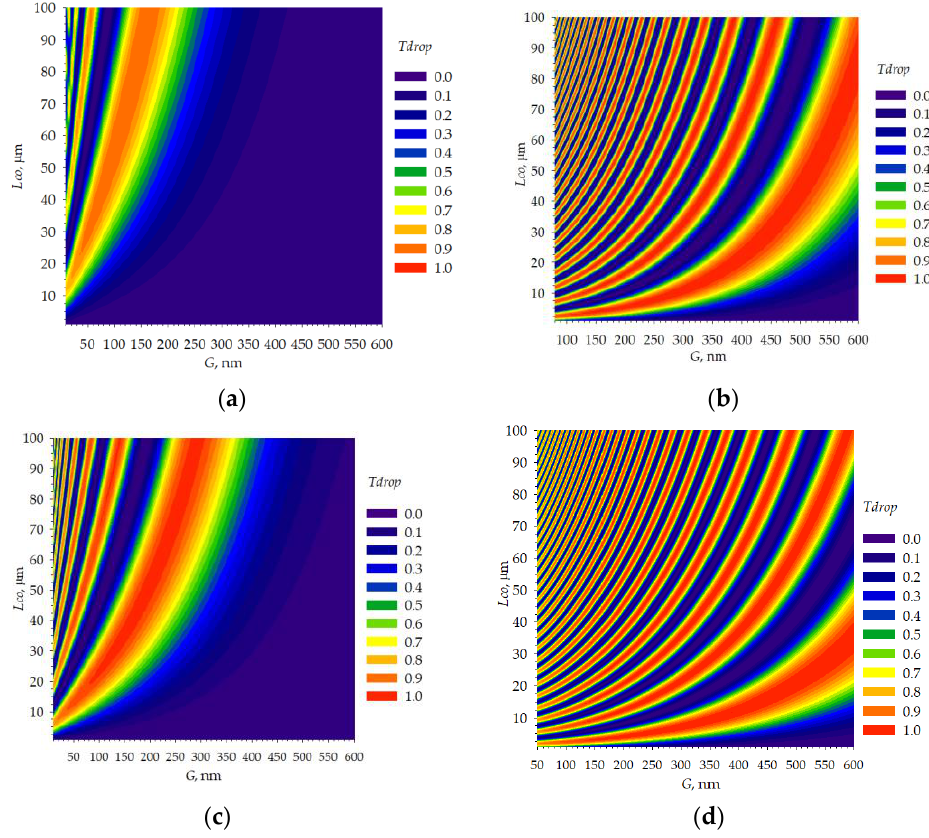
Figure 8. Dependence of the optical transmission coefficient of the directional coupler on the coupling length and gap. ( a ) Single-plane waveguides with dimensions of 300 × 1000 nm; ( b ) Different-plane waveguides with dimensions of 300 × 1000 nm; ( c ) Single-plane waveguides with dimensions of 300 × 750 nm; ( d ) Different-plane waveguides with dimensions of 300 × 750 nm.